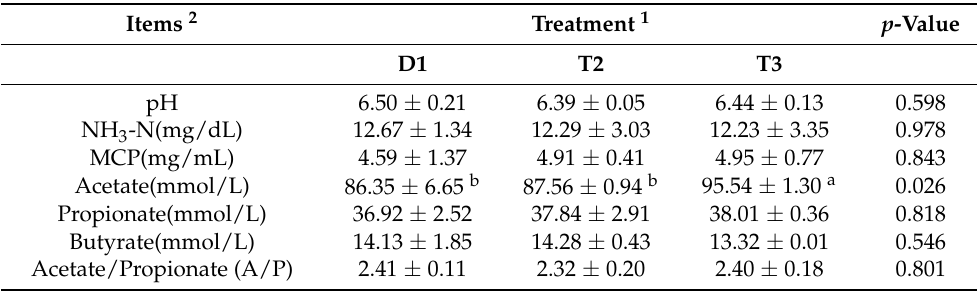
Table 6. Effects of low-protein dietary inclusion of RPLys and RPMet on rumen fermentation of Holstein